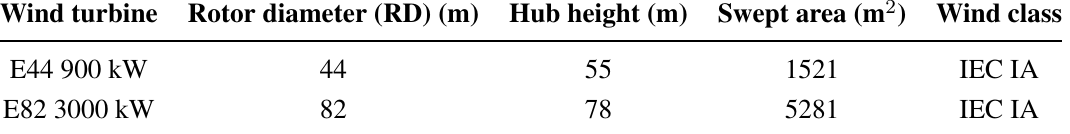
Table 2. Stats table over the Enercon E44 and E82 wind turbines. IEC: International Electrotechnical